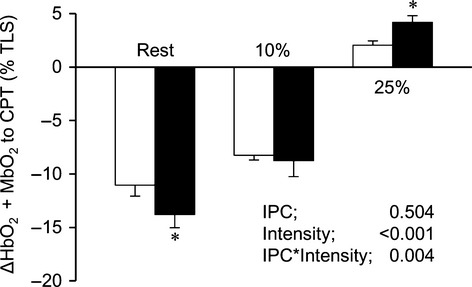
Group summary data of HbO2 + MbO2 changes in response to acute sympathetic stimulation with CPT at rest, 10% MVC, and 25% MVC. Data are means ± SEM. White bars represents CON and black bars represents IPC condition in total labile signal (TLS). *P < 0.05 between CON and IPC.